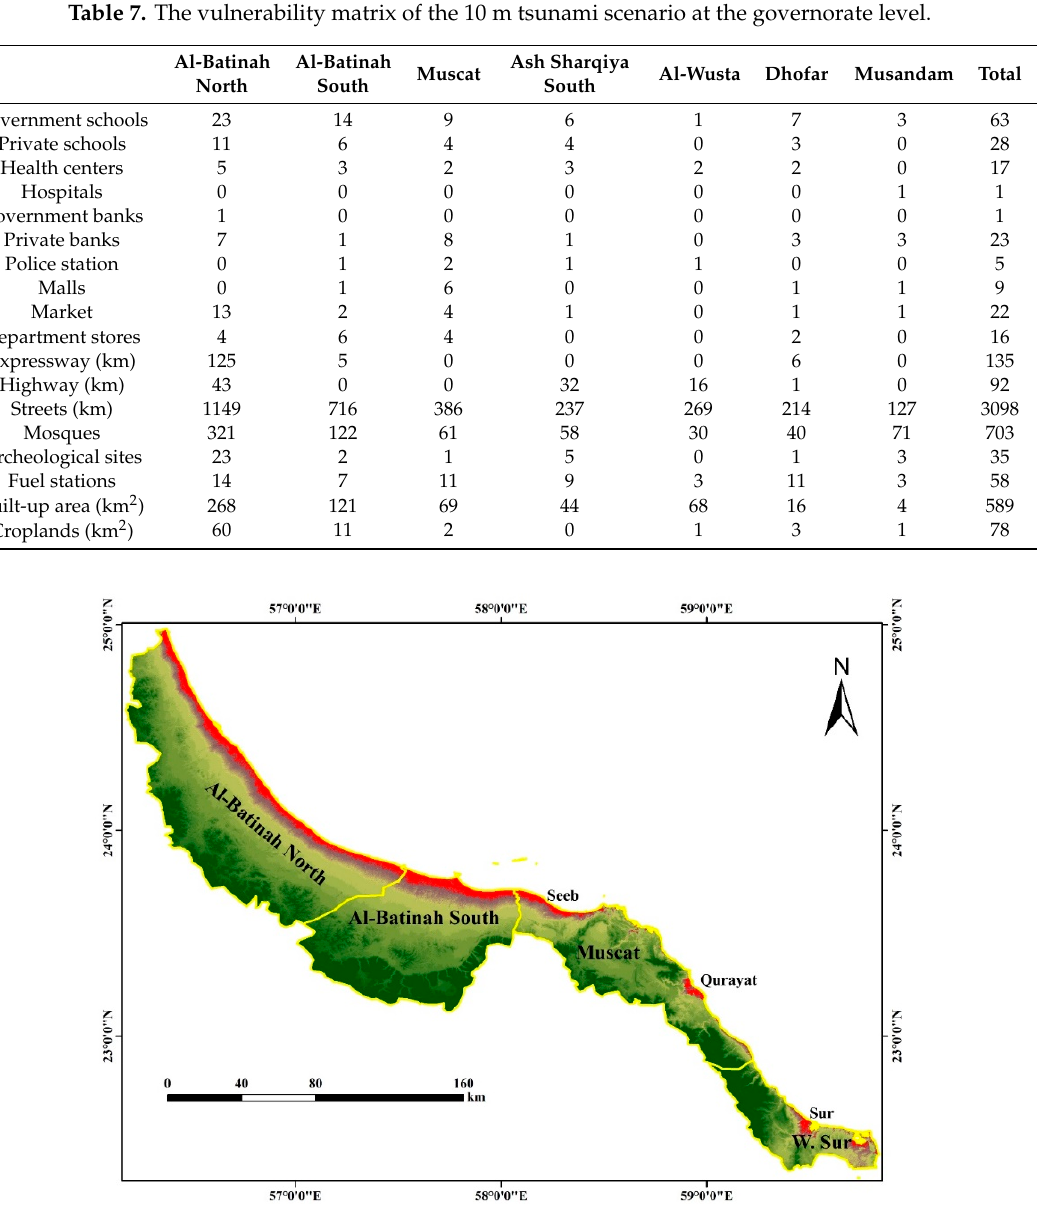
Figure 8. The coastal topography in North Oman. Note that red color highlights low-elevated coastal zones (below 10 m). Major low-lands occur at Al-Batinah North Governorate and Al-Batinah South Governorate along the Sea of Oman. Some coastal pockets occur at Muscat Governorate (such as at Willayat Seeb and Willayat Qurayat) and at Willayat Sur.